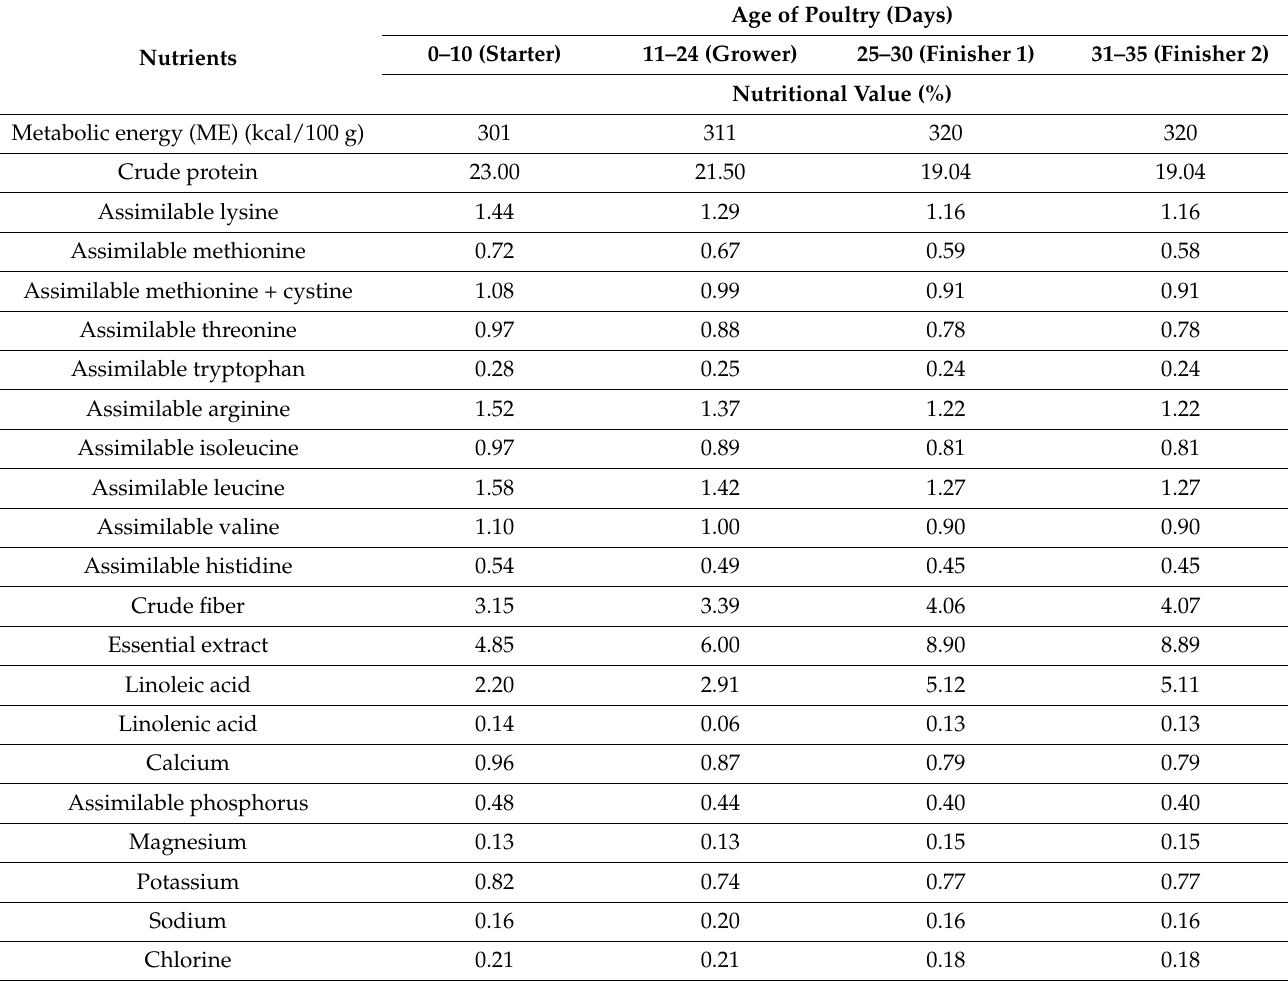
Table 3. Nutritional value of compound feeds for broiler